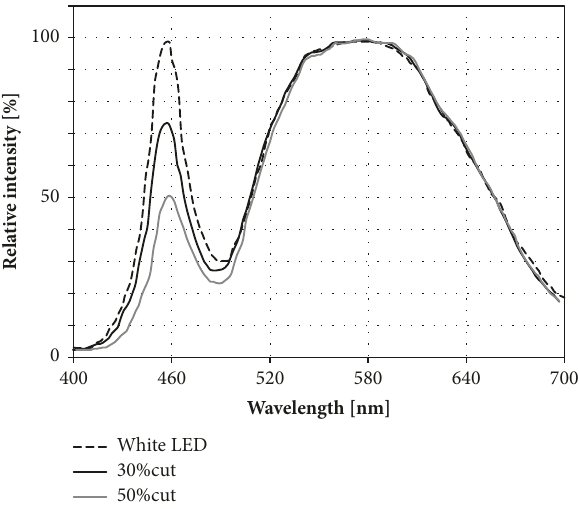
Figure 2: The relative spectral radiant intensity of light with short- wavelengthcontentreduced by 30% or 50% compared to